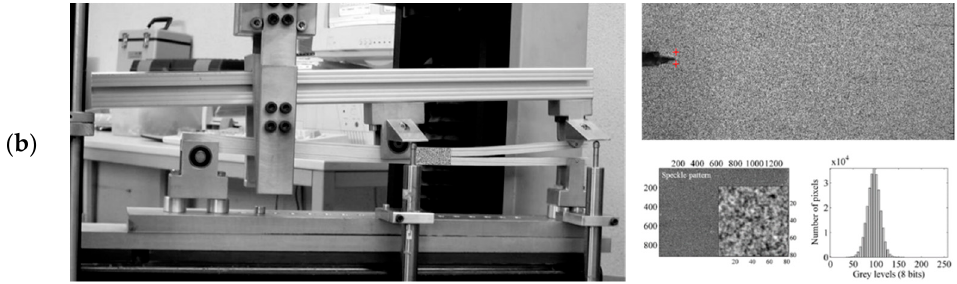
Figure 2. ( a ) MMB specimens oriented in the RL propagation system; ( b ) MMB set-up coupled with digital image correlation (DIC) (speckle pattern and its histogram over a region of interest of 29 × 20 mm 2 ).